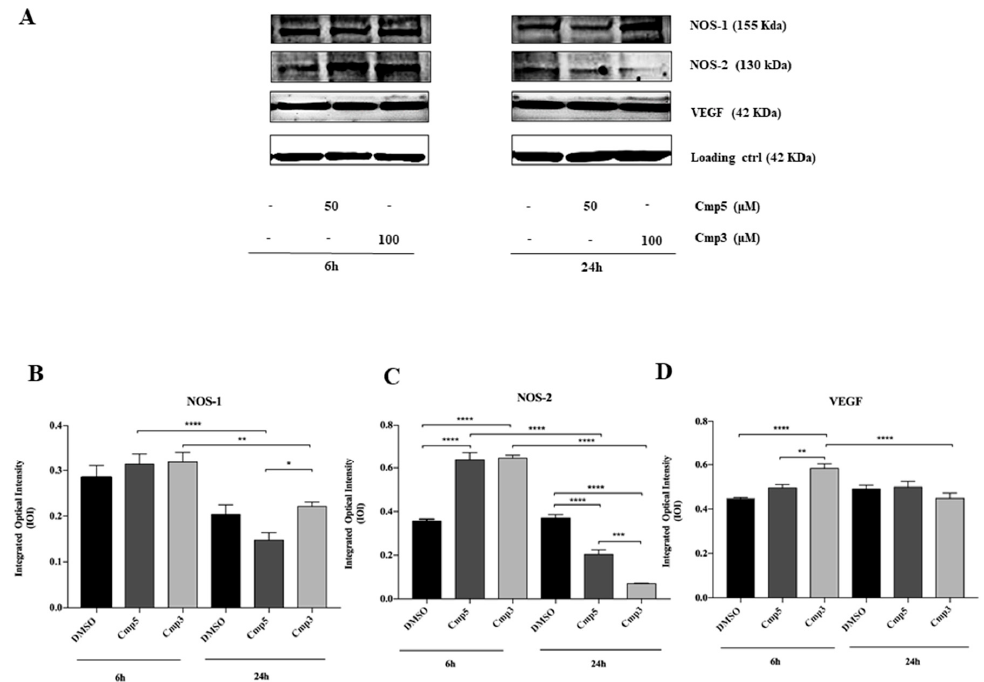
Figure 7. Western blotting analysis of NOS-1, NOS-2 and VEGF expression in rat C6 glioma cell lines treated with Cmp 5 and Cmp 3 . ( A ) Cells treated with DMSO (0.2%) were loaded as the negative control. Each membrane has been probed with β –actin antibody to verify loading consistency.